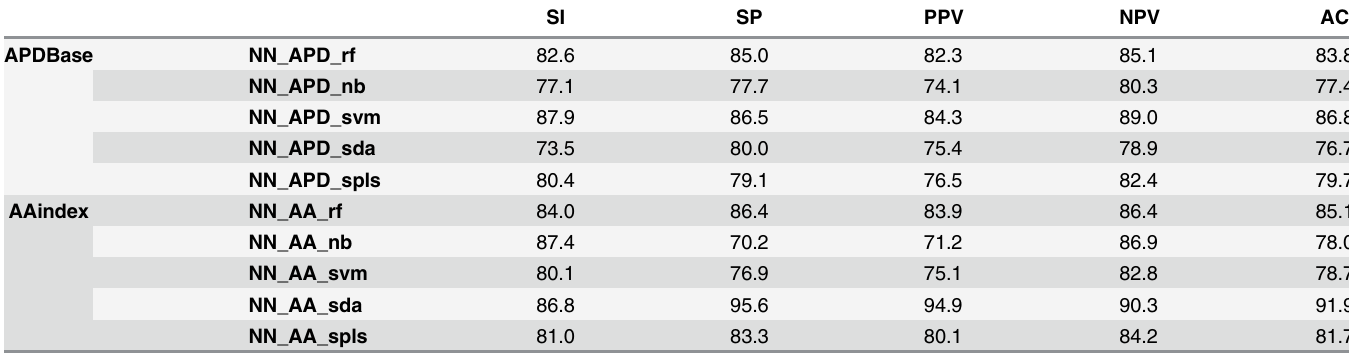
Table 1. Training sequences dataset classification results (%) for the selected neural networks obtained through APDBase or AAindex encoding, after feature selection with one of the internal classifiers, rf, nb, svm, sda and spls. Where SI is the sensitivity, SP the specificity, PPV the positive pre- dictive value, NPV the negative predictive value and AC the overall accuracy, averaged after 10-fold stratified resampling. SI